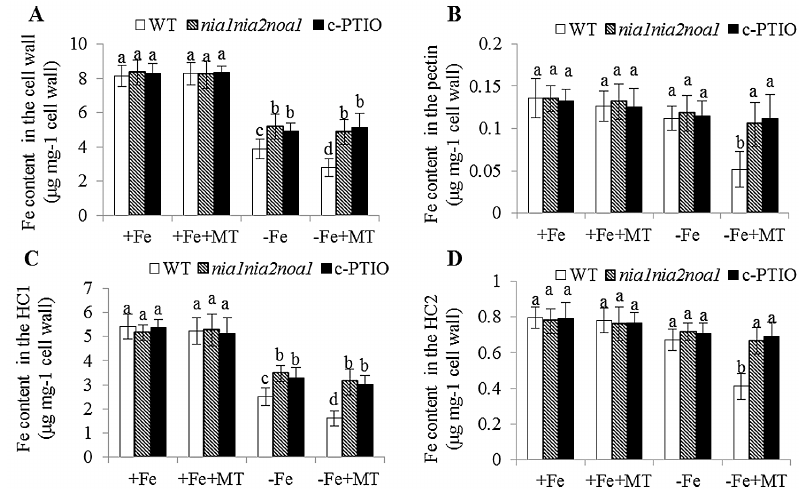
Figure 7. The effect of exogenous melatonin on Fe content in root cell wall components in the WT, nia1nia2noa1 and c-PTIO-treated Arabidopsis plants. Seven-day-old seedlings were grown in − Fe (0 μ M Fe) or +Fe (50 μ M Fe) medium without or with the presence of 5 μ M melatonin (+MT) for 8 days. Then, these plants were taken to measure the Fe content in the root total cell wall ( A ), pectin ( B ), HC1 ( C ), and HC2 ( D ) fractions. Each bar is the mean ± SE of at least three replicates, and different lowercase letters above the bars indicate significant difference using Tukey’s test at p < 0.05.